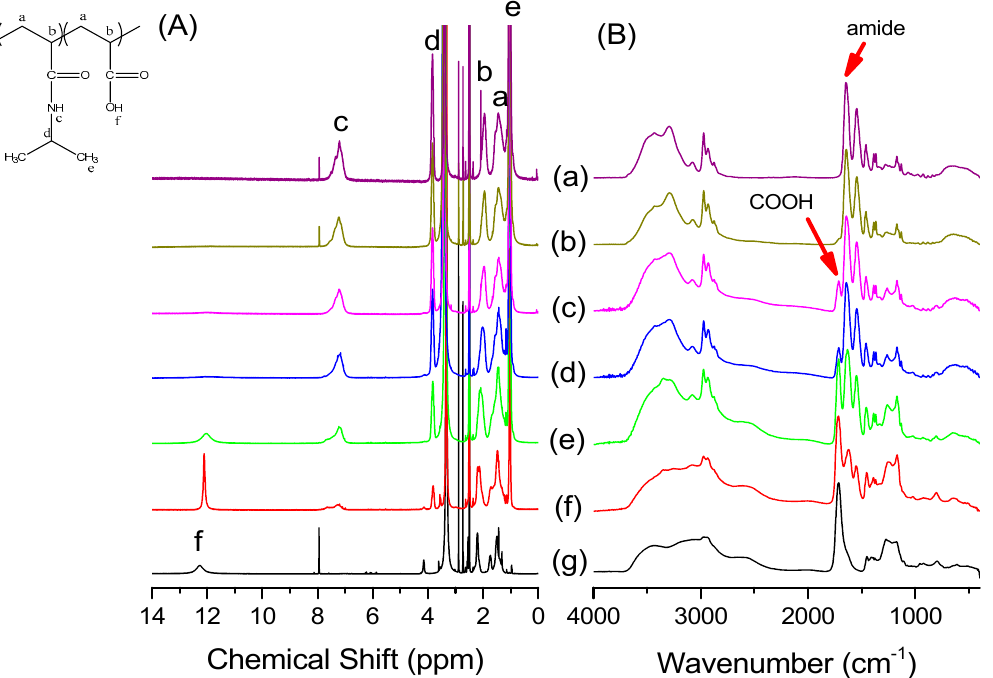
Figure 1. ( A ) 1 H NMR; and ( B ) FTIR spectra of: (a) pure PNIPAAm; (b) PNIPAAm97- co -PAA3; (c) PNIPAAm87- co -PAA13; (d) PNIPAAm80- co -PAA20; (e) PNIPAAm57- co -PAA43; (f) PNIPAAm30- co -PAA70; and (g) pure PAA.